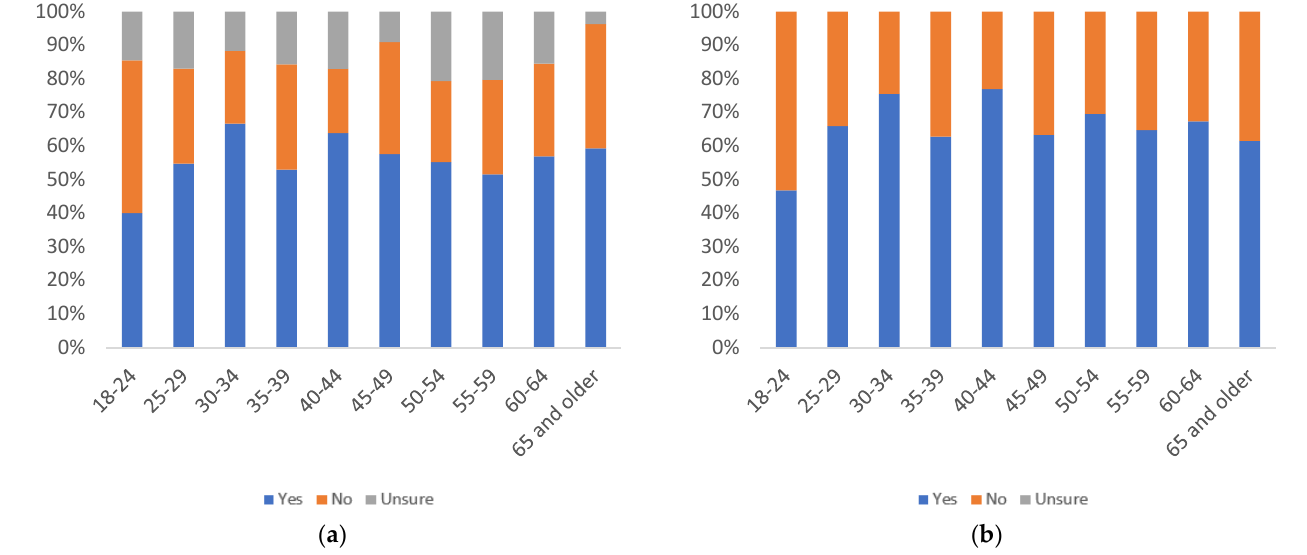
Figure 27. Label use, by age group: ( a ) with uncertain respondents (left) and ( b ) without uncertain respondents (right).